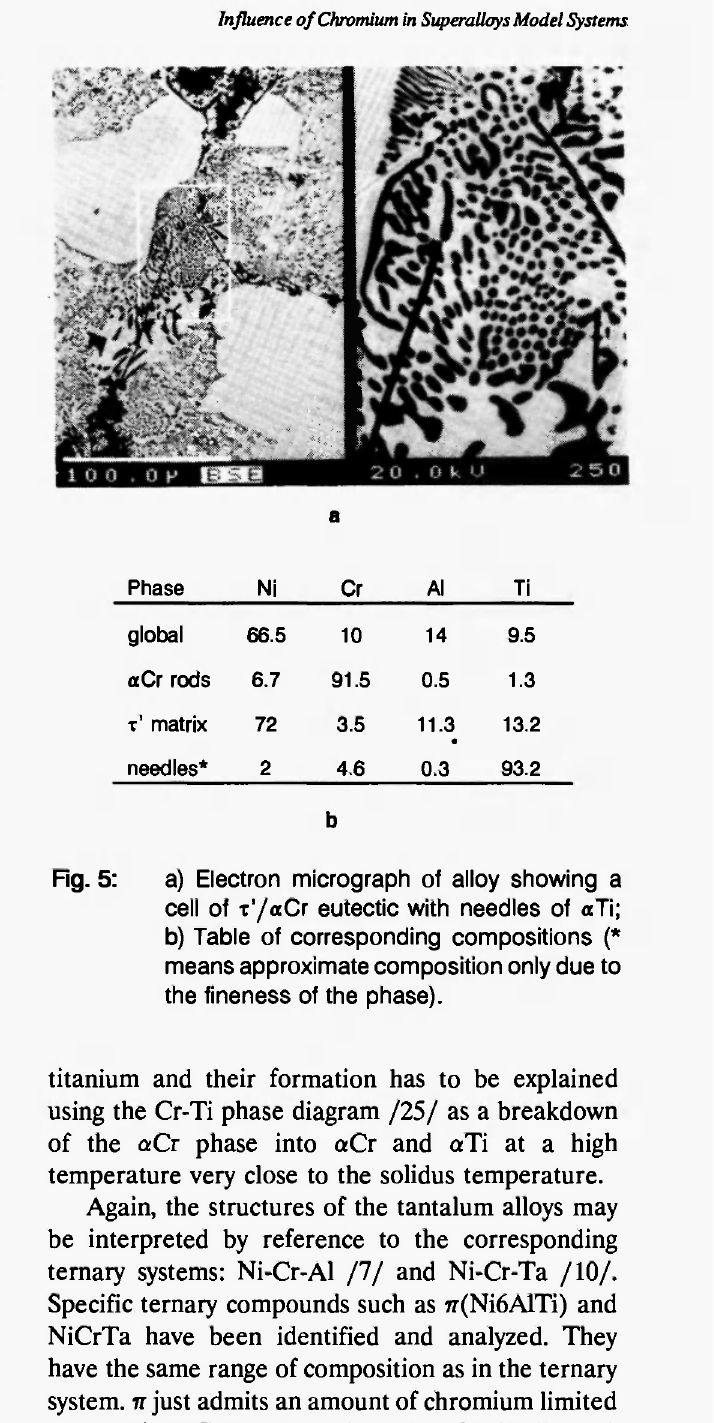
Fig. 5: a) Electron micrograph of alloy showing a cell of t'/aCr eutectic with needles of aTi; b) Table of corresponding compositions (* means approximate composition only due to the fineness of the